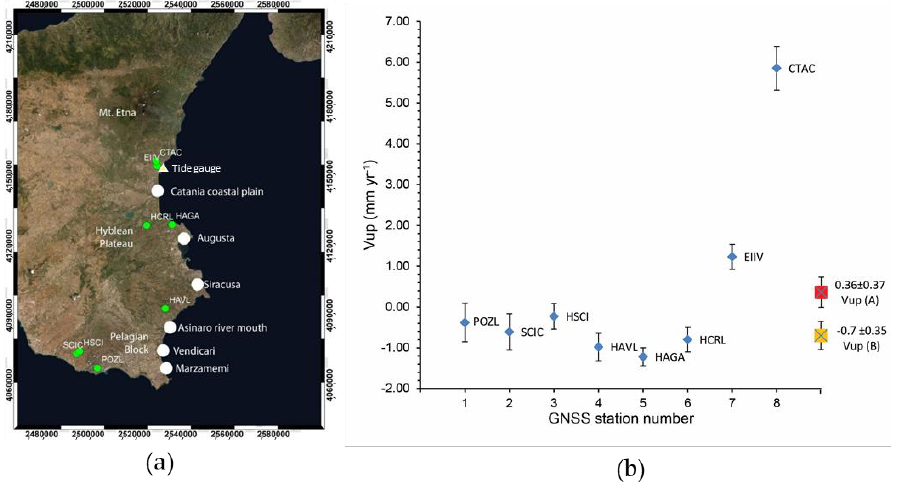
Figure 2. Study area of south-eastern Sicily (basemap by Google Satellite); ( a ) Location of the six investigated sites along the coast of southern Sicily (white dots) and position of the GNSS stations (green dots). ( b ) Vertical land velocities (Vup, mm/year) estimated at the GNSS stations located between Catania and Capo Passero within 10 km of the coast. The red and orange squares show the mean Vup values: Vup (A) includes the GNSS stations located at the foot of the Etna Volcano which recorded the uplift linked with the latest eruption activity; Vup (B) is the mean velocity excluding CTAC and EIIV which are located close to Etna. 3. The vertical velocities fit the GIA values for this region which have been estimated between −0.5 and −1 mm/yr [29].